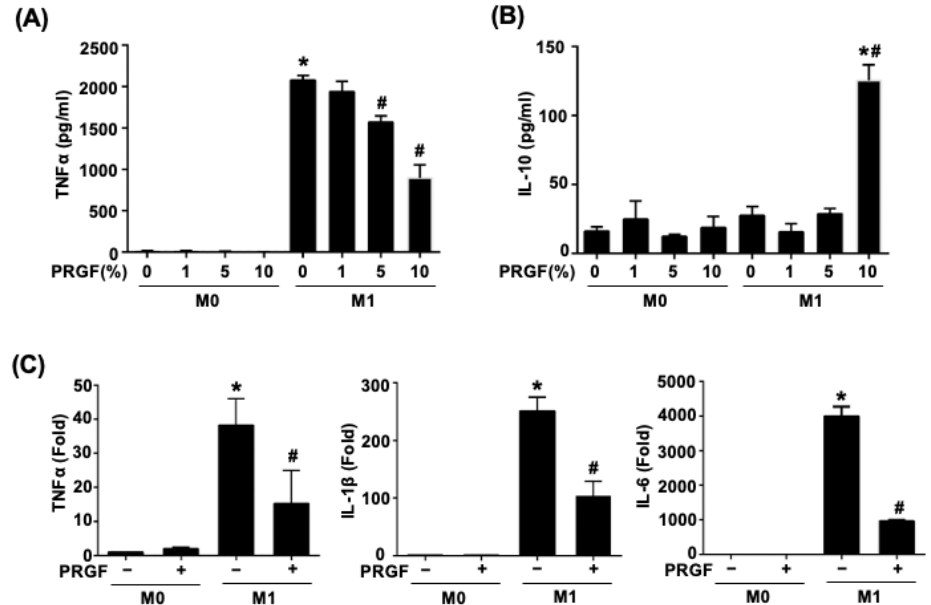
Figure 1. PRGF reduces both the secretion and expression of pro-inflammatory cytokines from M1 macrophages. ( A ) TNF α secretion decreased in M1 macrophages when treated with 5 and 10% PRGF compared to untreated M1 macrophages as checked by ELISA. ( B ) The concentration of anti- inflammatory cytokine IL-10 increased in M1 macrophages after treatment with 10% PRGF for 24 h. ( C ) The increases in mRNA expression levels of TNF α , IL-1 β , and IL-6 in M1-induction media were inhibited by adding 10% PRGF as checked by qRT-PCR. n = 3. Significance was assessed by one-way ANOVA. Data are presented as the mean ± SEM. * p < 0.05 versus M0. # p < 0.05 versus M1.